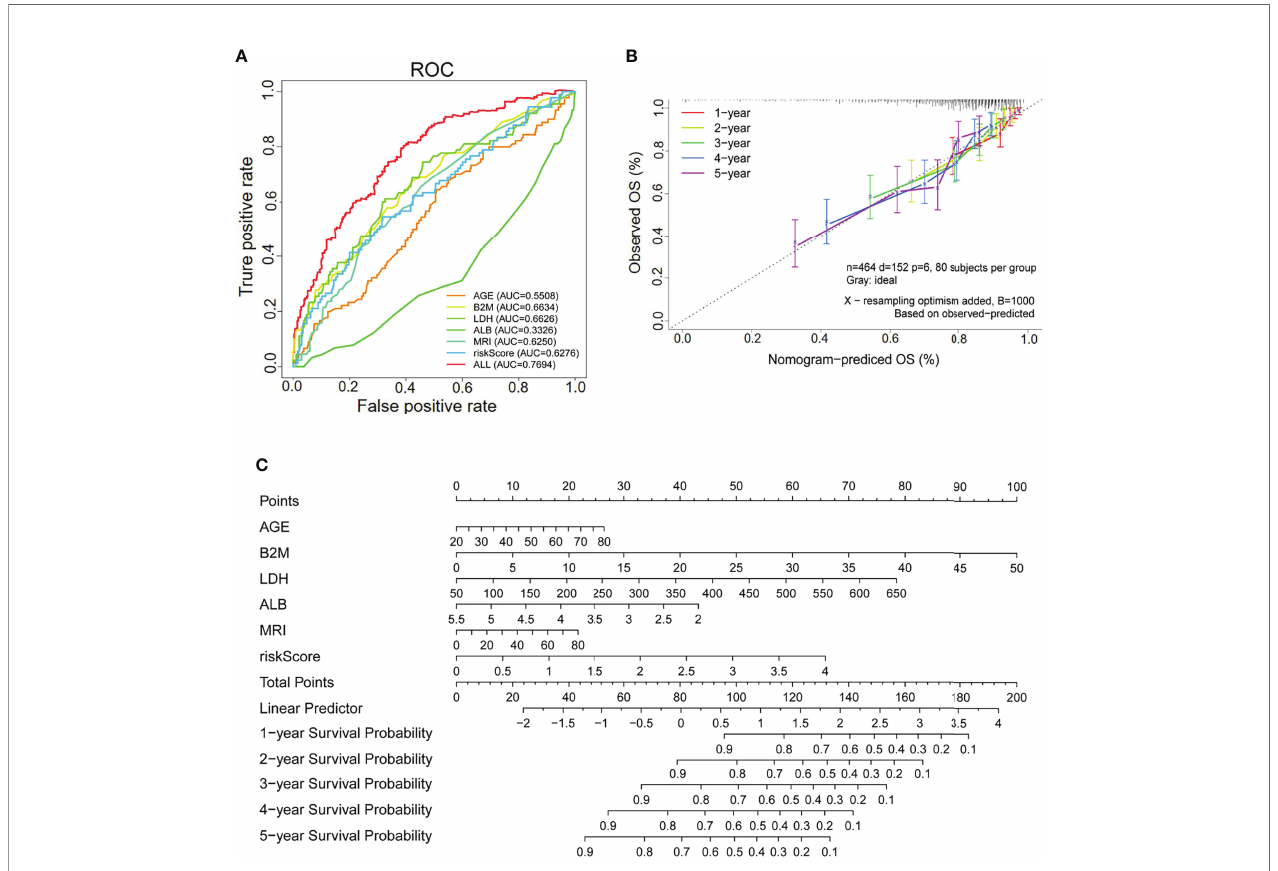
FIGURE 8 | The SLC19A1 risk score and clinical risk parameters with multivariate Cox regression analysis. (A) ROC curves are utilized to compare the predictive performance for AGE, B2M, LDH, ALB, MRI, riskScore, and ALL to predict patient survival. (B) The calibration curves for predicting 1-, 2-, 3-, 4-, and 5-year overall survival. (C) Establishment of a nomogram for prediction of 1-, 2-, 3-, 4-, and 5-year survival of MM